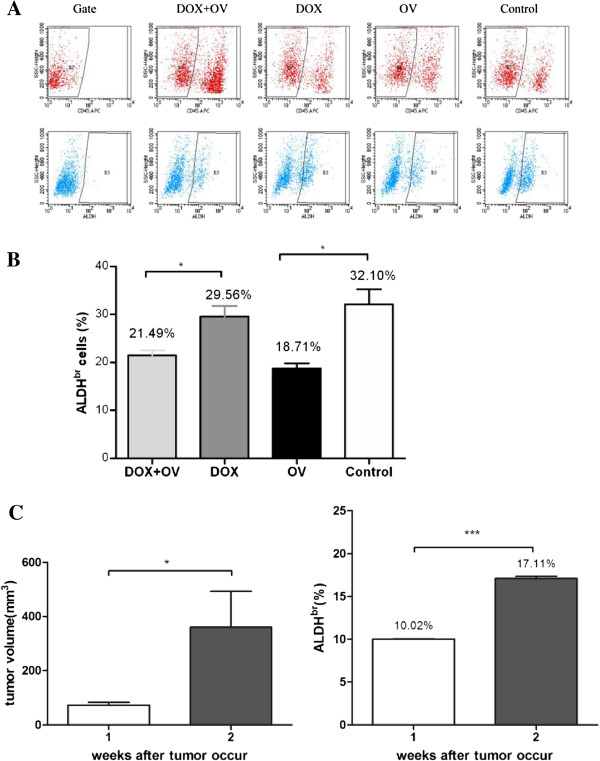
The influence of doxorubicin and/or HSV1-hGM-CSF on ALDHbr tumor cells in vivo. (A) An aldefluor assay of ALDHbr in in vivo-treated primary tumors as described in the Methods section. Representative images of flow cytometry from the four groups are depicted. The upper panels are the gates to exclude APC anti-mouse CD45+ leukocytes. The percent of CD45- cells was as followed: 33.45% for DOX+OV, 58.89% for DOX, 56.54% for OV and 61.69% for Control. (B) The mean frequency of ALDHbr tumor cells in the four groups are as follows (n=4-5). The experiment was performed twice with similar findings. (C) The influence of the primary tumor volume on 4T1 ALDHbr cells in vivo. The mean tumor volume (left), and the mean percentage of ALDHbr tumor cells (right, n=3-5) both increased with time. The data represent the mean ± SEM in triplicate. *, p < 0.05; ***, p < 0.001. Abbreviations: DOX, doxorubicin; OV, HSV1-hGM-CSF.